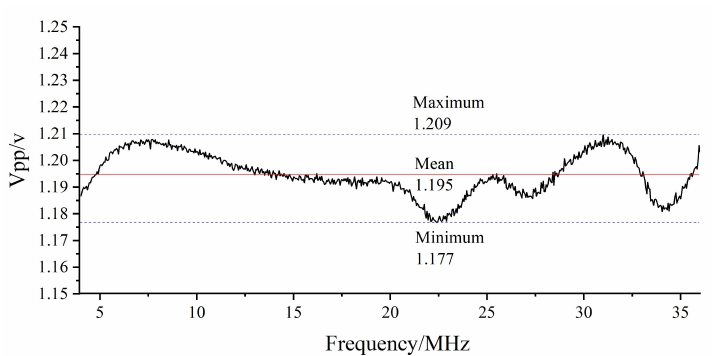
Figure 6. The relationship between the frequency and peak − to − peak value of the measured signal voltage after photoelectric